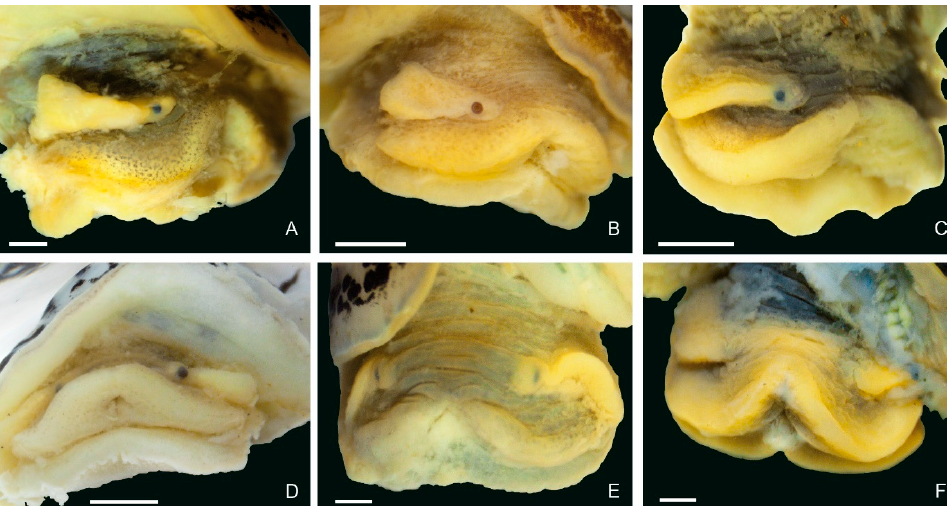
Figure 8. Variability in pigmentation on head and foot of Radix auricularia from Lake Baikal. Top row: view of right side, the dark point in the middle is the right eye. Bottom row: frontal view. ( A ) North of Cape Elokhin, 4–10 m depth ( Radix Baikal 4); ( B ) Maloye More, Kharin–Irgin Bay, 1.2 m depth ( Radix Baikal 7); ( C ) Pereyemnaja River at its mouth in to Lake Baikal ( Radix Baikal 32); ( D ) near Zarechnoe, 0.5 m depth ( Radix Baikal 22); ( E ) Maloye More, Shibetejskaya Bay, in a depth of 24–25 m ( Radix Baikal 11); ( F ) North of Buguldeyka, 2–3 m depth ( Radix Baikal 2). Scale bars = 1 mm. Male genitalia. The ratio of the length of the preputium to that of the penial sheath varies from 0.75–1.51 (n = 8). The basic colour of the preputium is yellow (Figure 9A), yellowish grey (Figure 9B–D,H), yellowish green (Figure 9G), or bluish grey (Figure 9E,F). In most cases, additional pigmentation on the proximal part is grey (Figure 9A) or bluish grey (Figure 9C,D,G,H), reminding of freckles (n = 6). In one case, the bluish grey prepu- tium has a dorsal pigmentation with yellow “freckles” (Figure 9E).